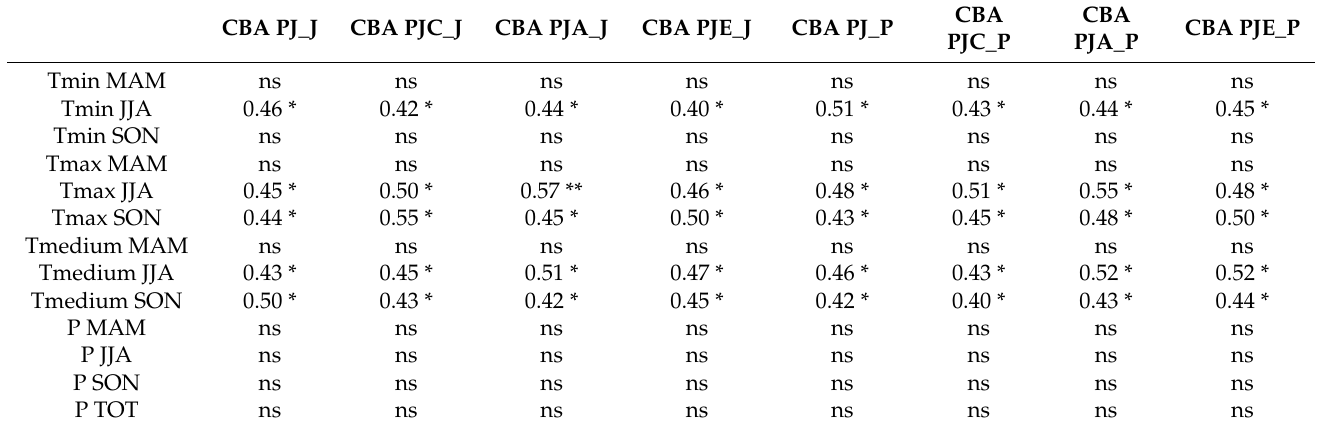
Table 1. Correlations between cumulative basal area (CBA) of each intercropping systems with average temperature (Tmean), minimum temperature (Tmin), maximum temperature (Tmax), and total precipitation (Ptot) grouped seasonally (MAM = March, April and May; JJA = June, July and August; SON = September, October and November). Spearman correlation coefficients are reported (r), with the corresponding statistical significance (* 0.05, ** 0.01) n = 25.